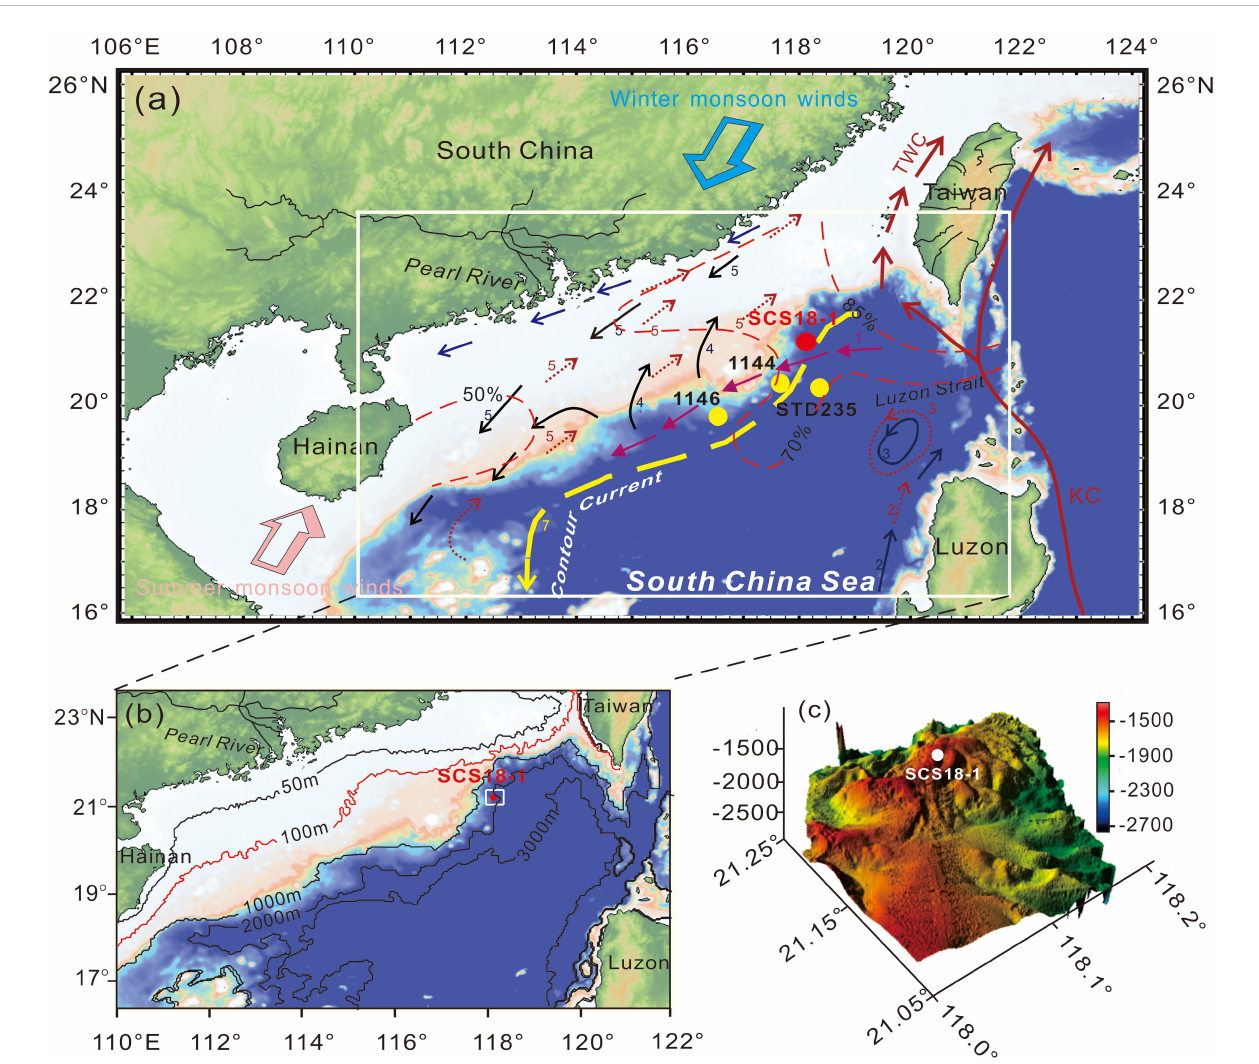
FIGURE 1 Map showing (A) the location of core SCS18-1 and the monsoon winds and current systems (modi fi ed from Liu et al., 2010b), (B) the submarine contour in the northern SCS, (C) the topography of the Beipo seamount. The location of cores ODP1144 (Liu et al., 2010b; Liu et al., 2013), ODP1146 (Wan et al., 2007b) and STD235 (Liu et al., 2018) are also shown. Southwesterly winds prevailing in summer (pink three-dimensional arrow) and northeasterly winds prevailing in winter (blue three-dimensional arrow); summer and winter surface currents (red dotted line arrow and black solid arrow, respectively); deep current (yellow dashed arrow); longshore current (blue solid arrow); Kuroshio current (KC); Taiwan current (TWC). Numbers for winter and summer surface currents: 1. SCS Branch of Kuroshio; 2. NW Luzon Coastal Current; 3. NW Luzon Cyclonic Eddy; 4. SCS Warm Current; 5. Guangdong Coastal